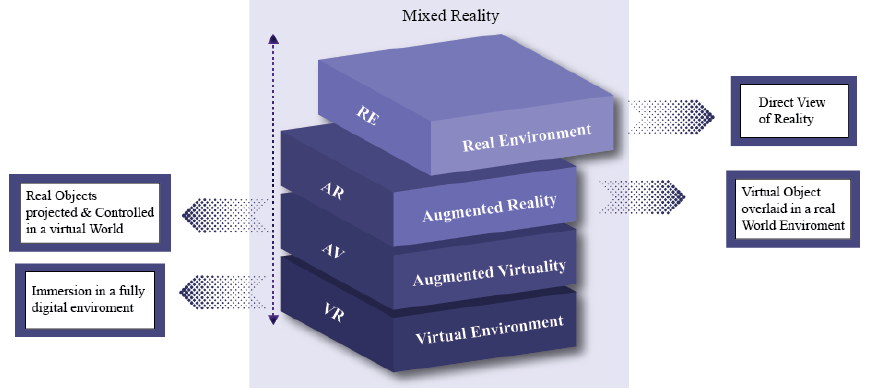
Figure 1. Milgram’s Reality–Virtuality Continuum